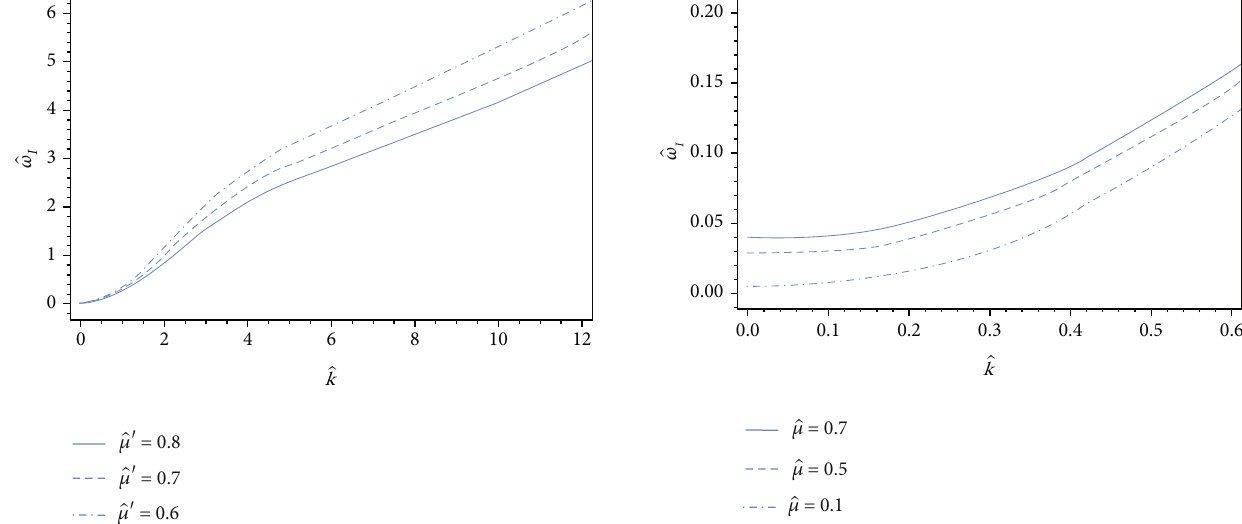
Figure 11: E ff ect of viscosity ratio of fl uids on growth rate curves at b ρ = 0 : 002 , Oh = 100 , b μ = 0 : 4 , L = 0 : 3 , b β = 0 : 6 , b ε = 0 : 3 , Ce = 3 , C m 2 = 6 , and ̂ H = 20 e 1